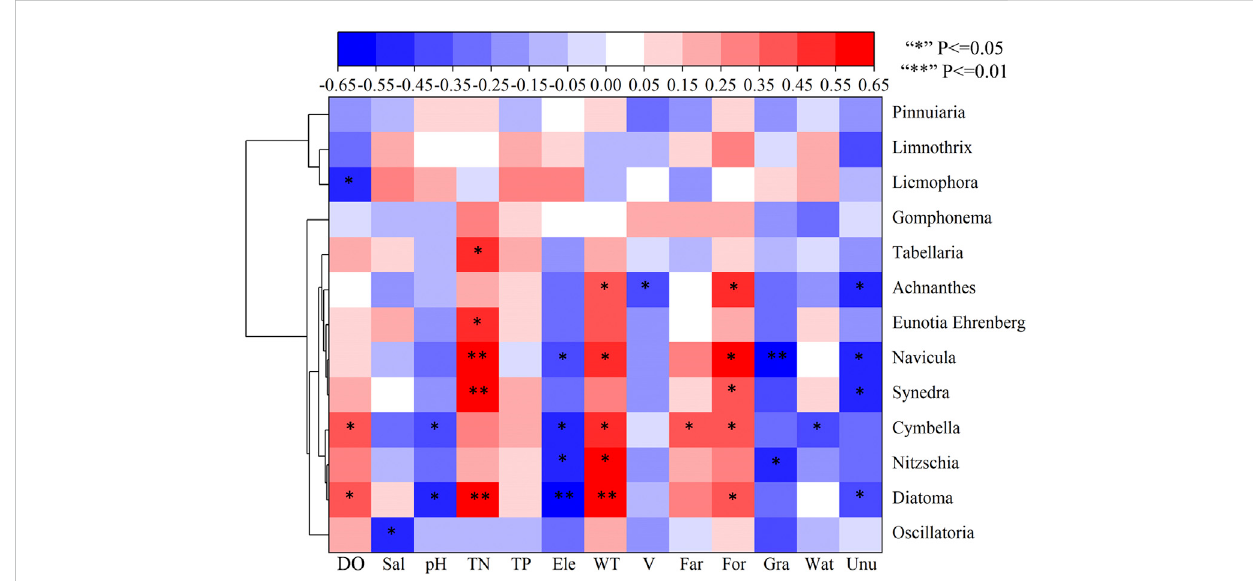
FIGURE 7 Cluster heat map analysis of correlation between environmental variables and dominant algae.